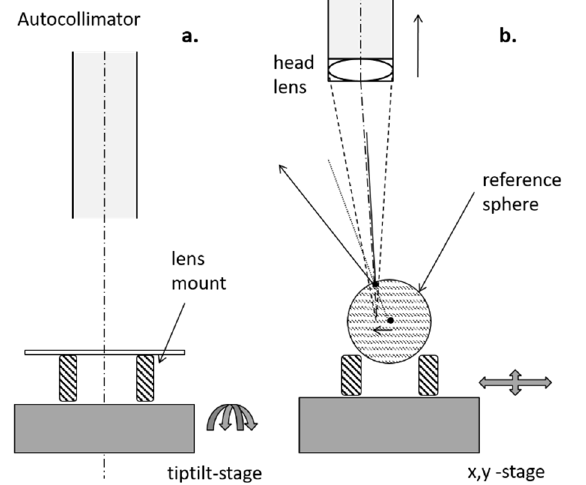
Fig. 1 . Adjustment of the optical mount with respect to the autocollimator. Left: angle adjustment. Right: the centre of the reference sphere is adjusted to coincide with the focal point of the autocollimator head